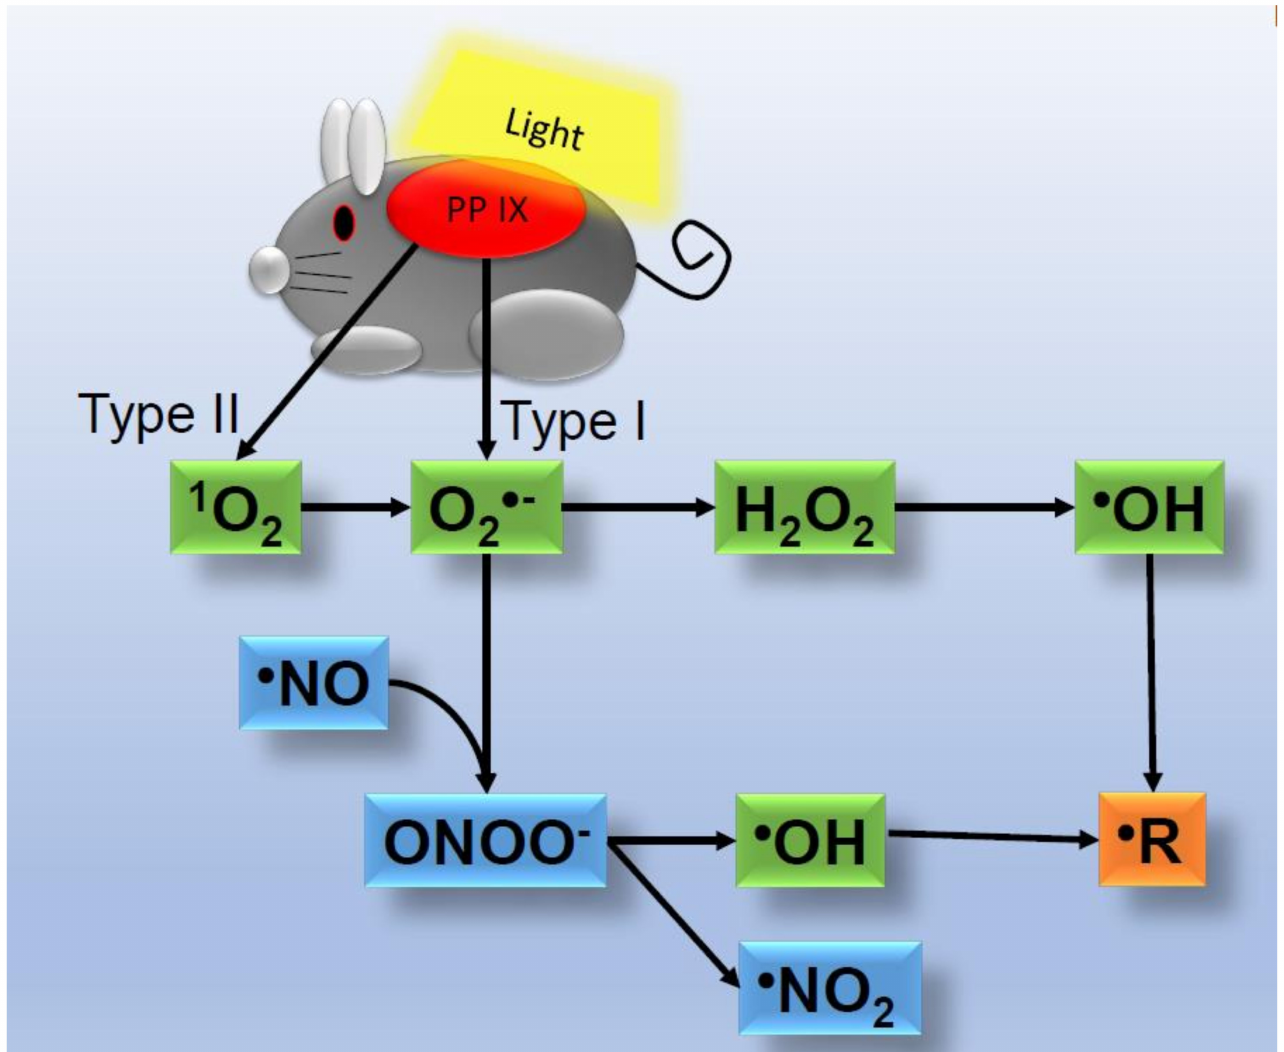
Figure 3. Detection of photo-induced free radicals in the skin of mice using an electron spin resonance method. Lipid radicals and • OH are generated in skin treated with protoporphyrin IX (PP IX) plus natural